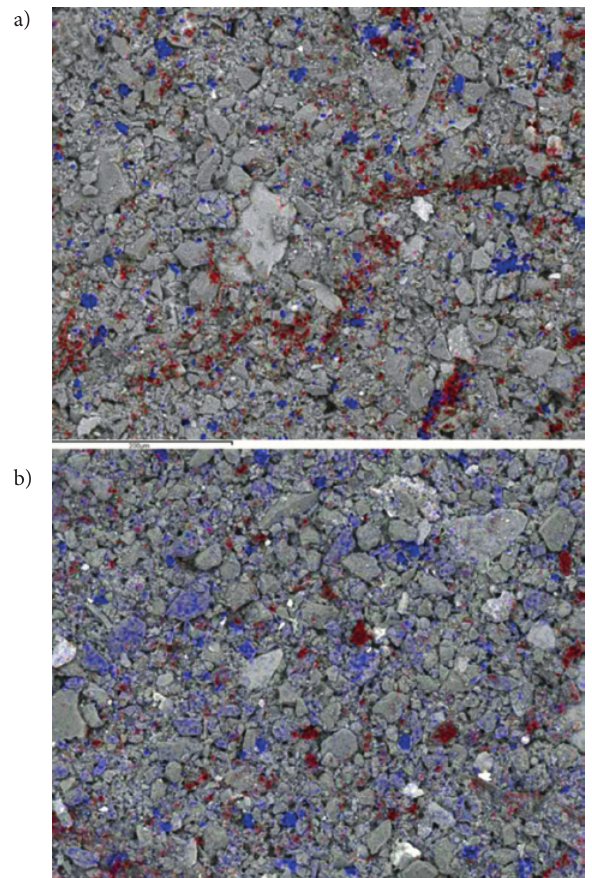
Fig. 4. Microscopic image of snow meltwater filter sediment sampled at 1 m distance from road: (1) dark-coloured measuring field; and (2) background measuring field for FTIR microscopy